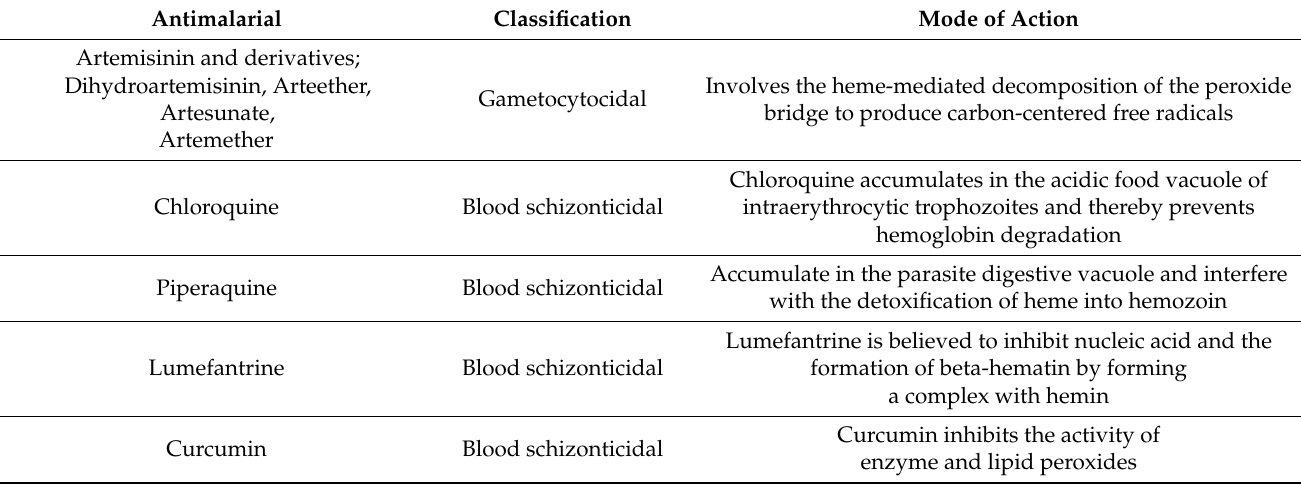
Table 1. Selected antimalarial drugs and their mode of action upon administration. Antimalarial Classification Mode of Action Artemisinin and derivatives; Involves the heme-mediated decomposition of the peroxide Gametocytocidal bridge to produce carbon-centered free radicals Chloroquine accumulates in the acidic food vacuole of Blood schizonticidal intraerythrocytic trophozoites and thereby prevents hemoglobin degradation Accumulate in the parasite digestive vacuole and interfere with the detoxification of heme into hemozoin Lumefantrine is believed to inhibit nucleic acid and the formation of beta-hematin by forming a complex with hemin enzyme and lipid